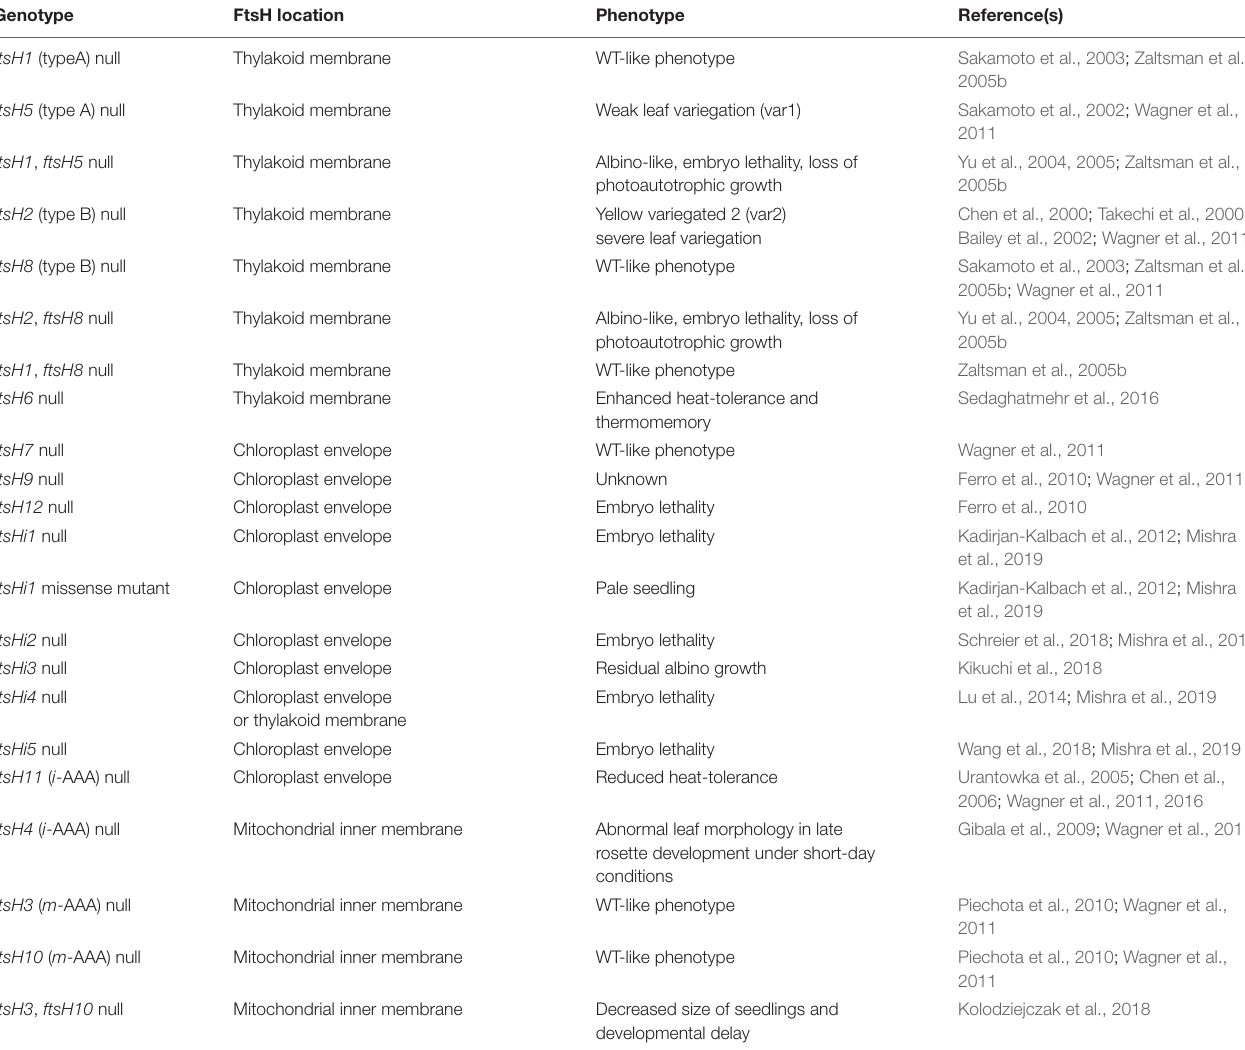
TABLE 1 | Summary of the phenotypes from FtsH mutants of Arabidopsis thaliana